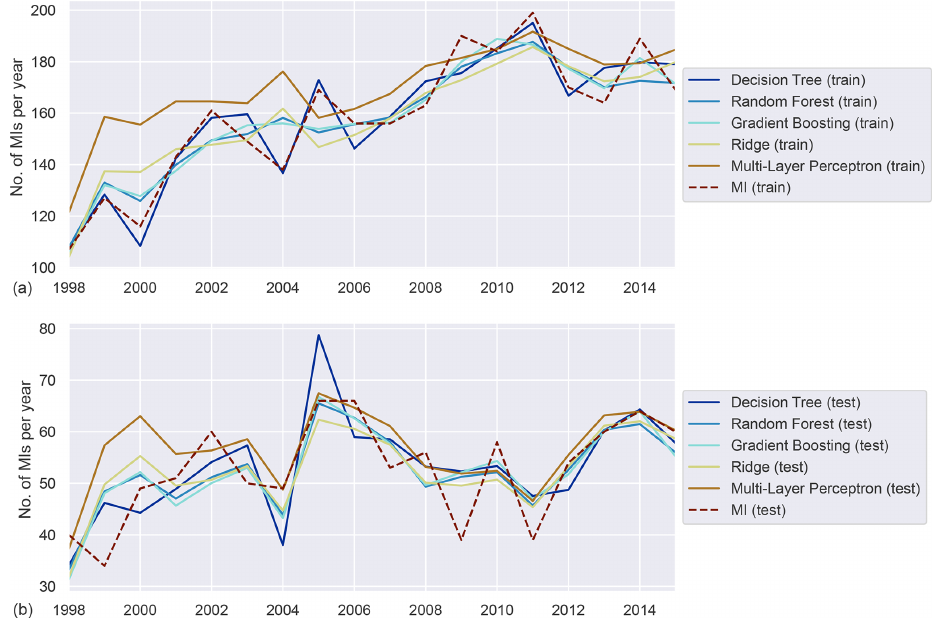
Figure A5. Annually aggregated predictions of MI in the smoking population for all models. Predicted (solid) and observed MI (dashed) for training (a) and test (b) sets.